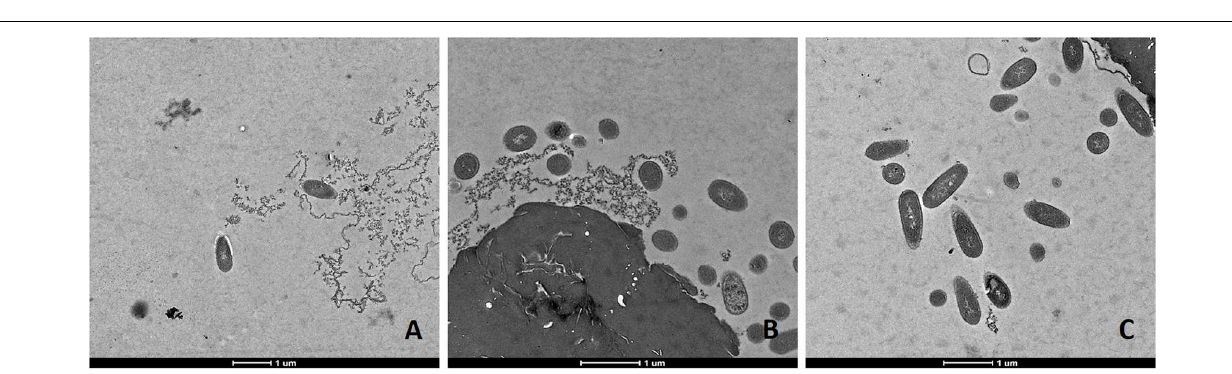
FIGURE 3 | Transmission electron microscopy (TEM) micrographs of untreated L. monocytogenes Li-P69 cells. Scale bar equals 500 nm (A–C) .